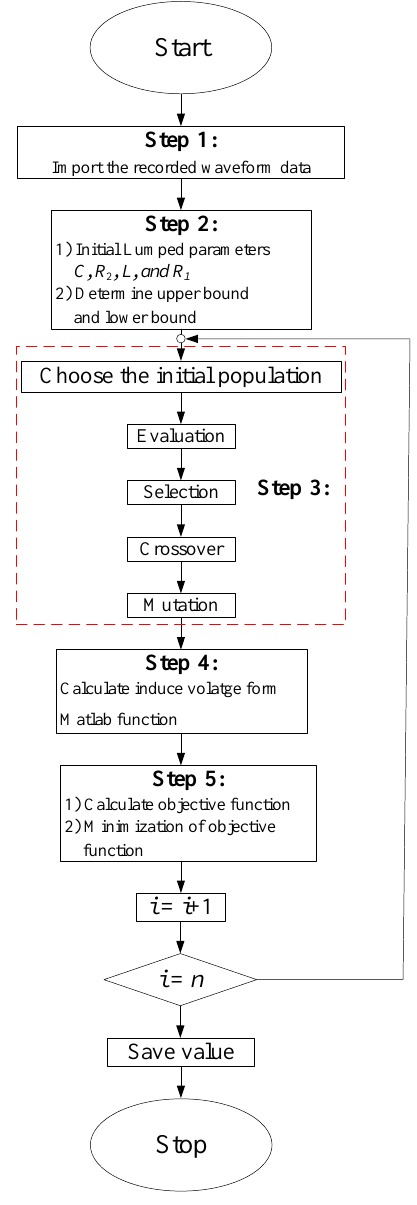
Figure 6. Flowchart of the proposed algorithm.